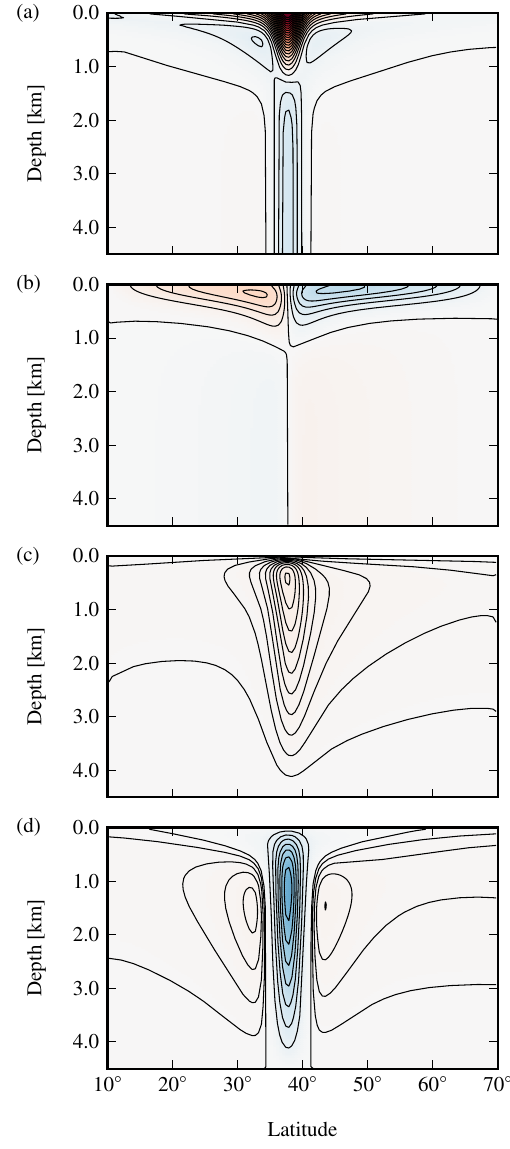
Fig. 10. Velocity fields for the nonconvective case: (a) interior zonal velocity u i (contour interval 0.5cms − 1 ), (b) western-boundary meridional velocity v w (contour interval 1cms − 1 ), (c) western- boundary vertical velocity w w (contour interval 0 . 2 × 10 − 5 ms − 1 ), and (d) eastern-boundary vertical velocity w e (contour interval 0 . 2 × 10 − 5 ms − 1 for positive values, 2 . 0 × 10 − 5 ms − 1 for nega- tive values). Red shading indicates positive values; blue shading indicates negative